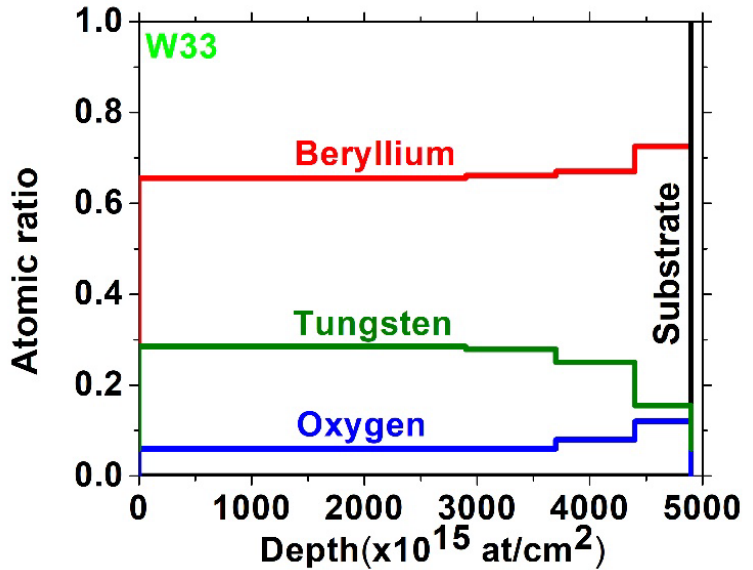
Figure 7. Depth profile of the W 33 sample depicting the element and impurity concentration in layer.